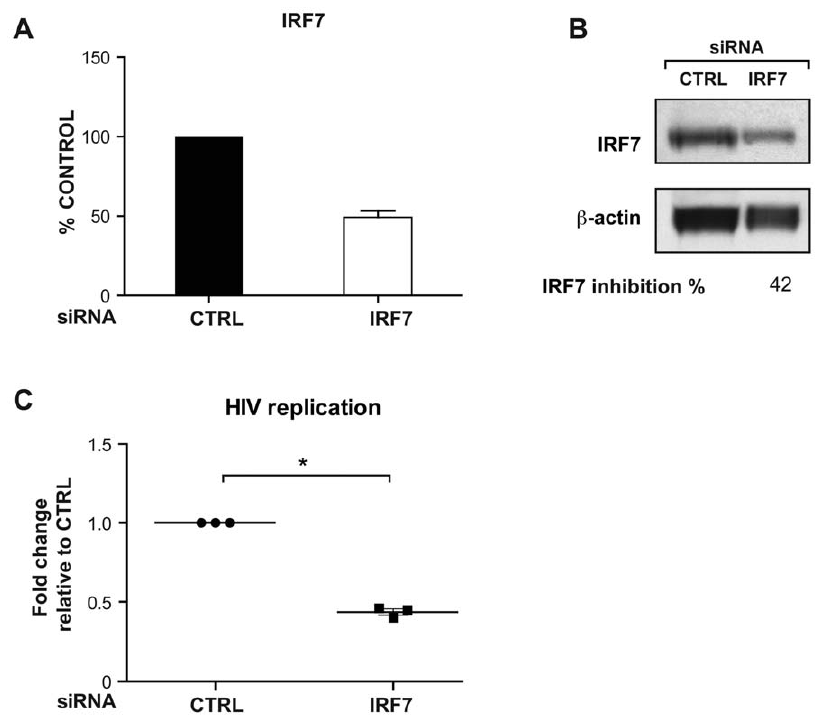
Figure 4. IRF7 expression modulates HIV-1 replication in primary macrophages. A) Level of IRF7 gene expression in macrophages treated with siRNA targeting IRF7 (50 nM) [n=3] compared to a control non-targeted siRNA [n=3] resulted in a 55% reduction in IRF7 gene expression. The qRT-PCR results were normalized to the level of 18 S. B) Western blot for IRF7 protein treated as in panel A shows a decrease of 42% for IRF7 protein. The densitometry of the bands was normalized to that of b -actin. Results shown are representative of 2 independent experiments. C) Level of TAT spliced expression following inhibition (51%) by IRF7 as compared to control. The qRT-PCR results were normalized to the level of 18 S. An * denotes a significant difference (P , 0.001, one sample t -test) compared to the negative control siRNA. Each symbol in a group represents one independent donor.